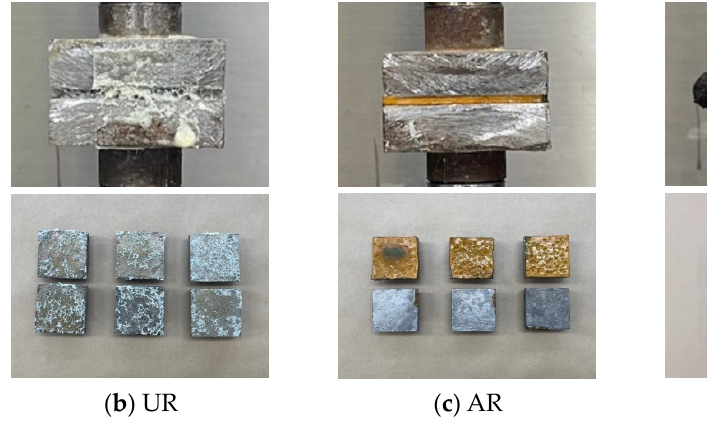
Figure 3. Adhesion testing of each GILRM specimen type.